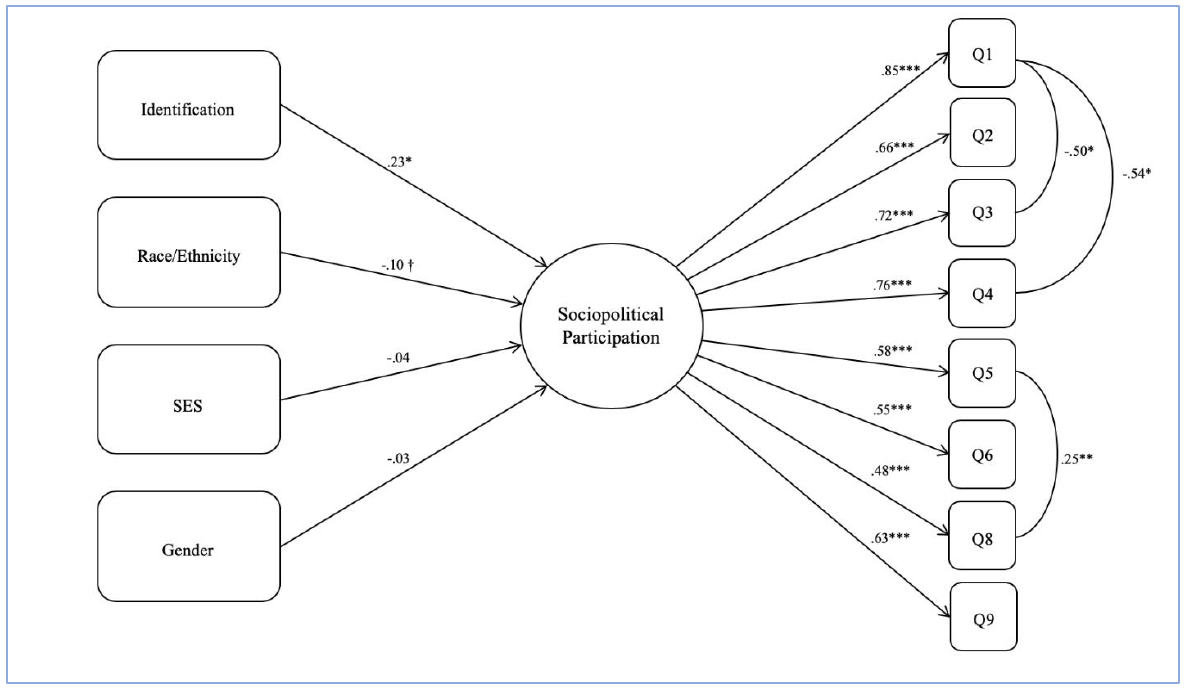
Figure 2. Multiple Indicator and Multiple Causes (MIMIC) Model With Political Identification as Exogenous